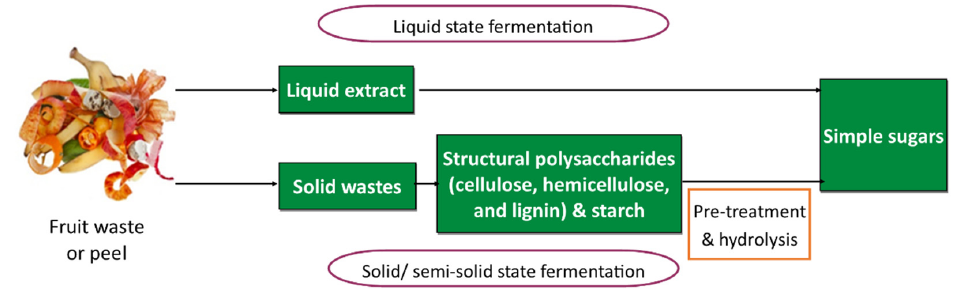
Figure 3. Bioconversion of fruit waste.